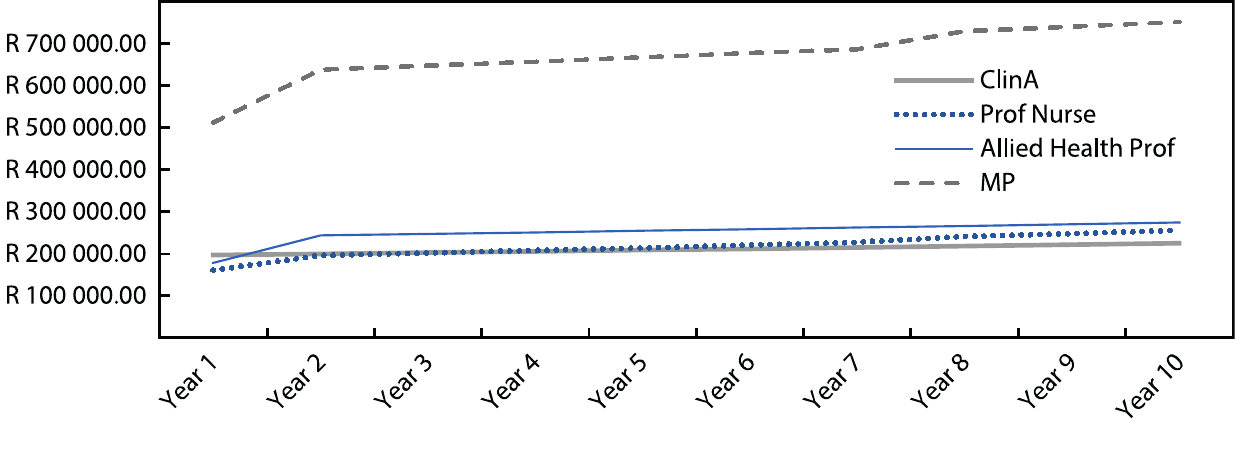
Figure 2: Comparison of salary notches for 4 healthcare professionals over the first 10 years of